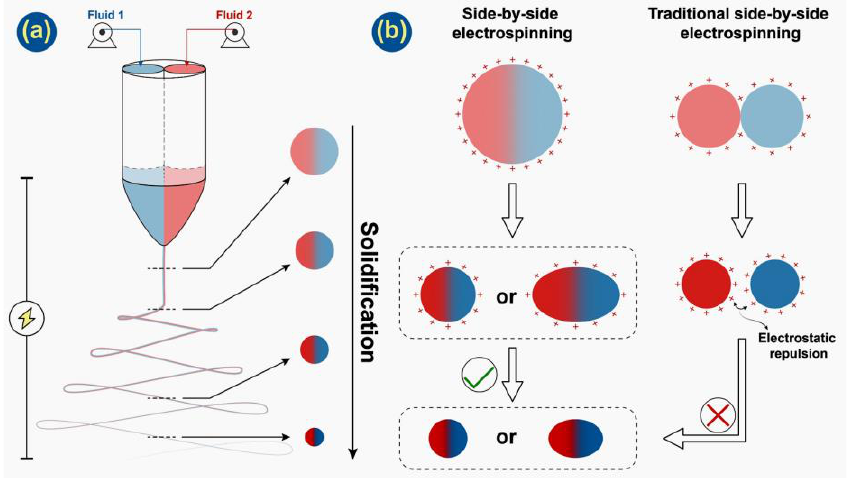
Figure 5. ( a ) Solidification process of working fluid along with side-by-side electrospinning; ( b ) charge distribution on the surface of this work compared with traditional side-by-side electrospinning.